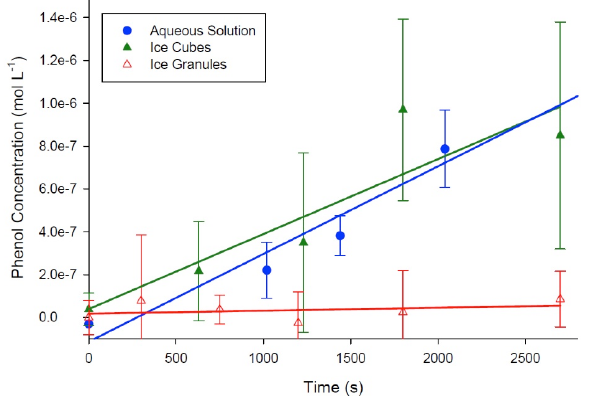
Fig. 18. Formation of phenol from in situ photolysis of H 2 O 2 in the presence of benzene in liquid solution and different ice samples. Phenol concentration is plotted as a function of irradiation time for samples containing 1mM benzene and 0.9mM H 2 O 2 . The solid traces are linear fits to the data, and error bars represent one standard deviation about the mean for at least three trials. Reprinted from Kahan et al. (2010b). Copyright by the